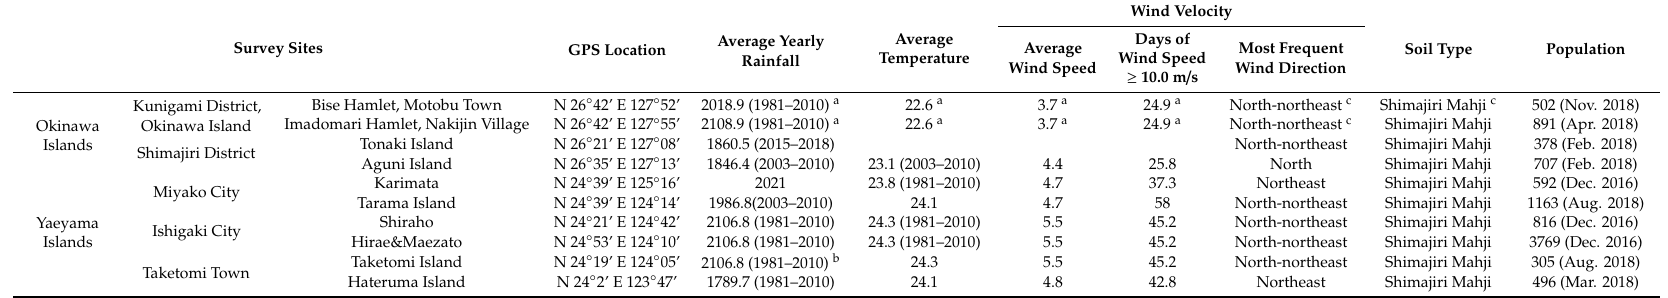
Table 1. Meteorological, natural, and demographic descriptions of survey